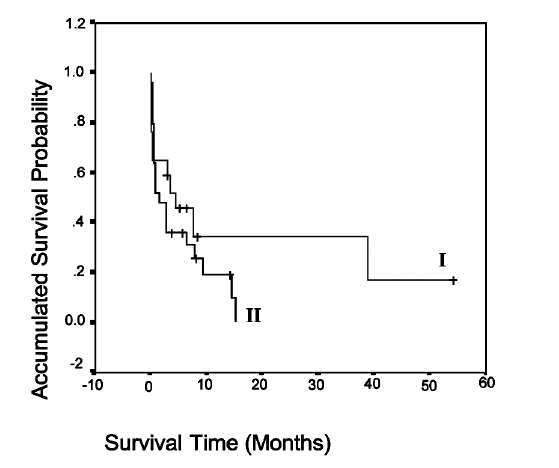
Figure 5 – Survival of patients who did not require preoperative urgent dialysis (I) and patients who required preoperative dialy- sis (II), p =